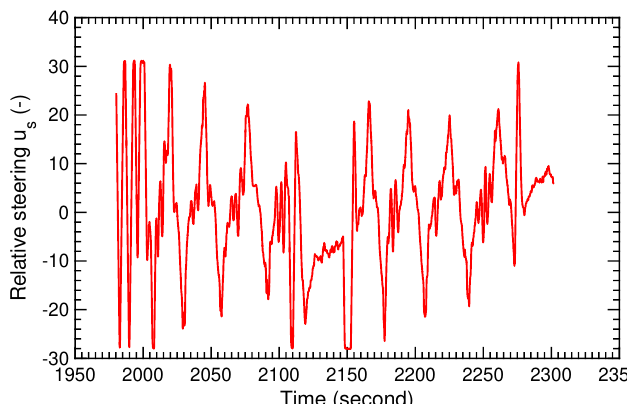
Figure 29. Recorded relative steering action u s for two pumping cycles.